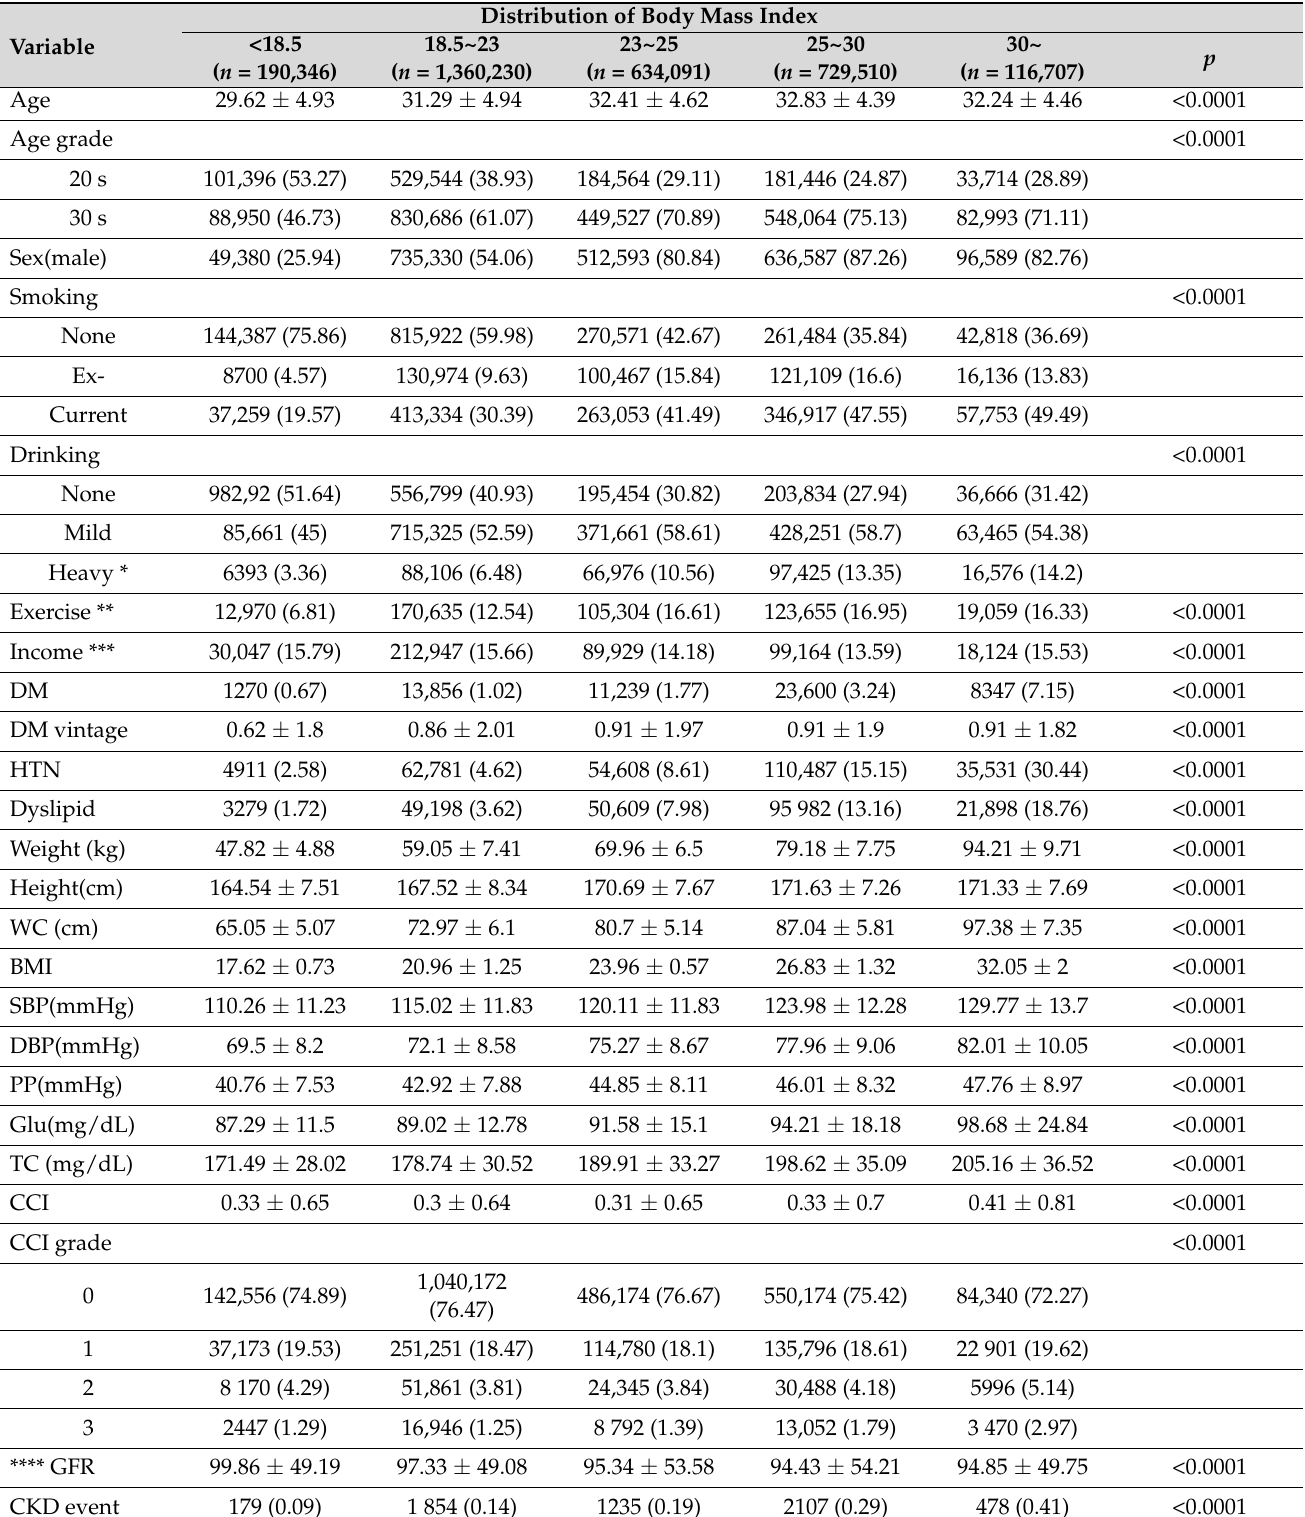
Table 2. Baseline characteristics of participants by level of body mass